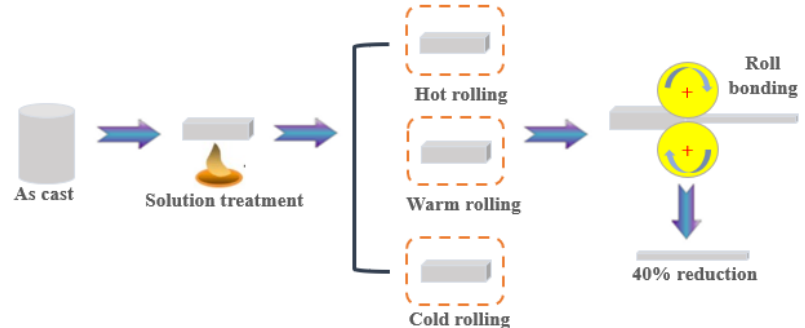
Figure 1. Schematic diagram of the three processing routes.